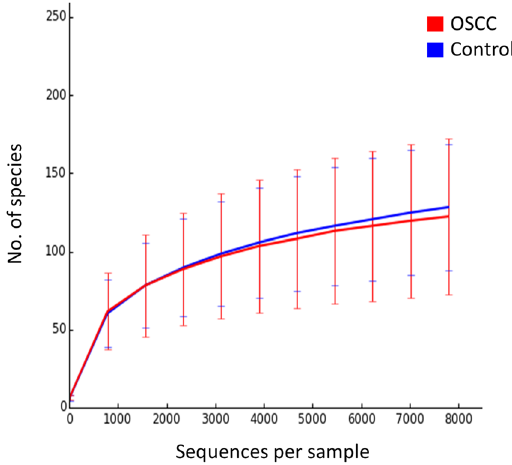
Figure 2. Rarefaction curves showing the number of observed species as a function of sequencing depth.